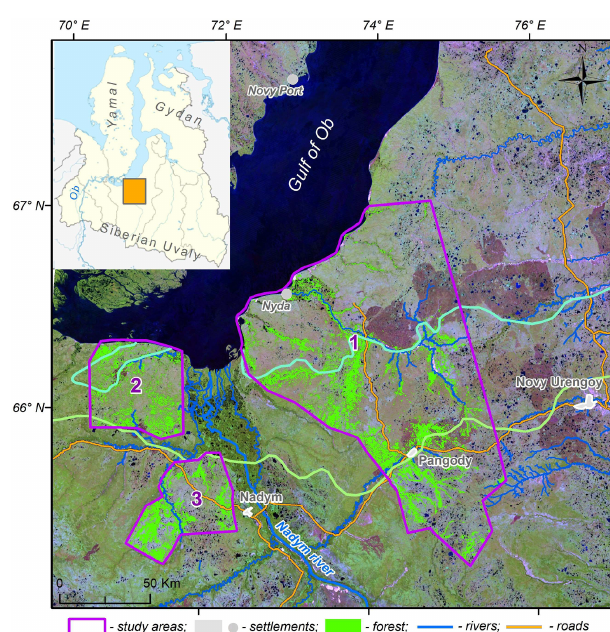
Table 2. Classification of vegetation classes based on growing